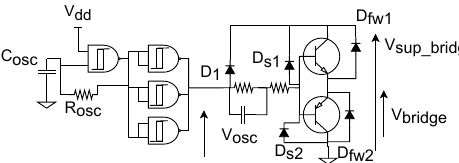
Figure 5. Oscillator and transformer